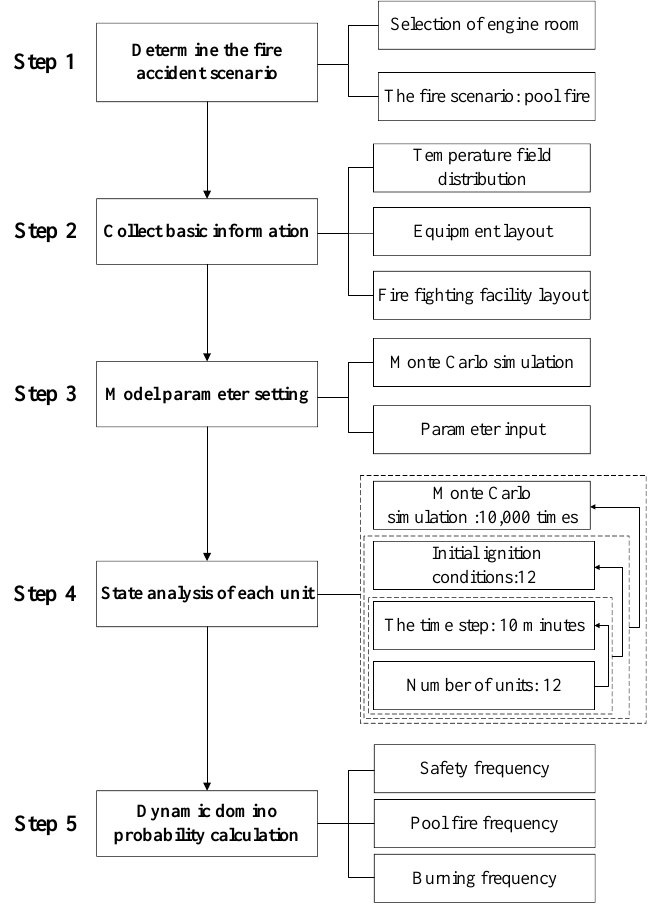
Figure 3. Flowchart for calculating the dynamic probability of domino effect in an engine room fire.